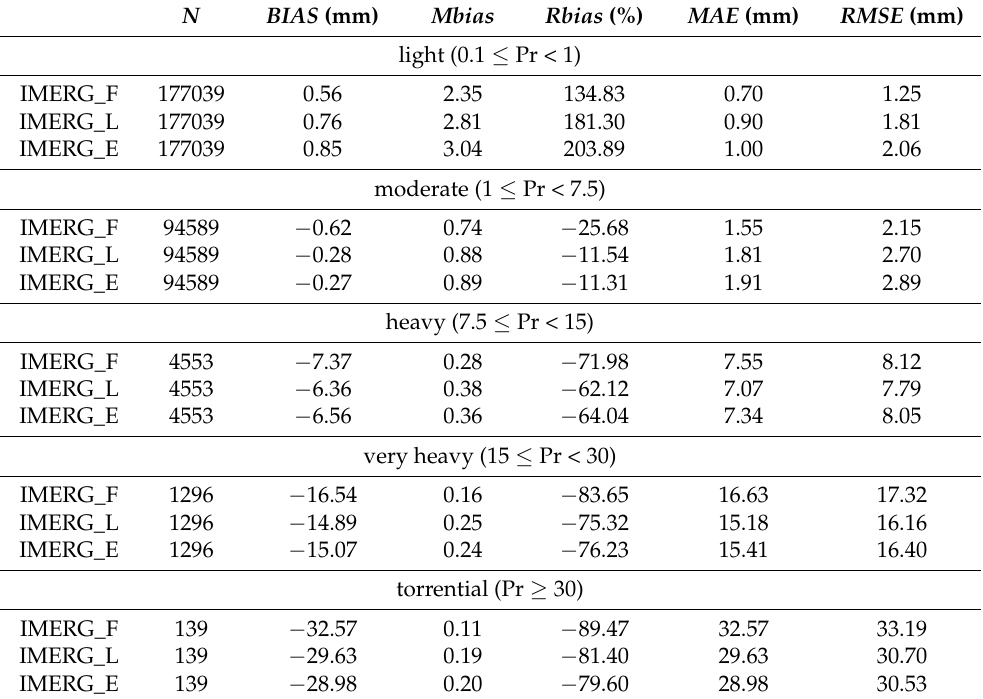
Table 5. Summary of statistics calculated according to the intensity of rainfall recorded by rain gauges in 30